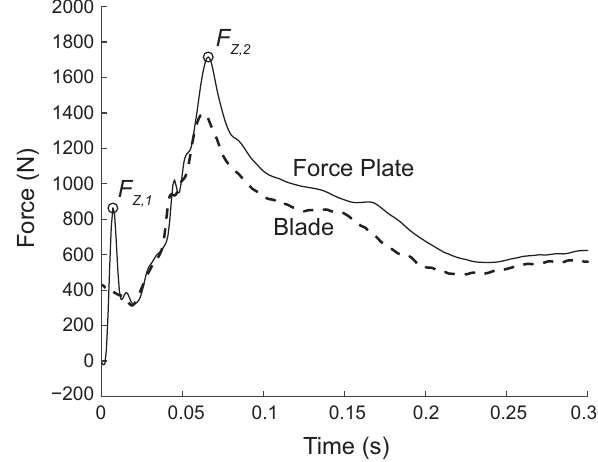
Figure 4. Comparison of forces measured by the force plate and the blade from a representative drop landing. The blade force was calibrated from ten drop / jump landings onto the force plate. The blade force and force plate force typically agreed in overall shape, but disagreed in the presence of the initial impact peak, F Z ,1 , (usually present in the force plate force but not in the blade force), and the height of the second peak F Z ,2 , (usually higher in the force plate